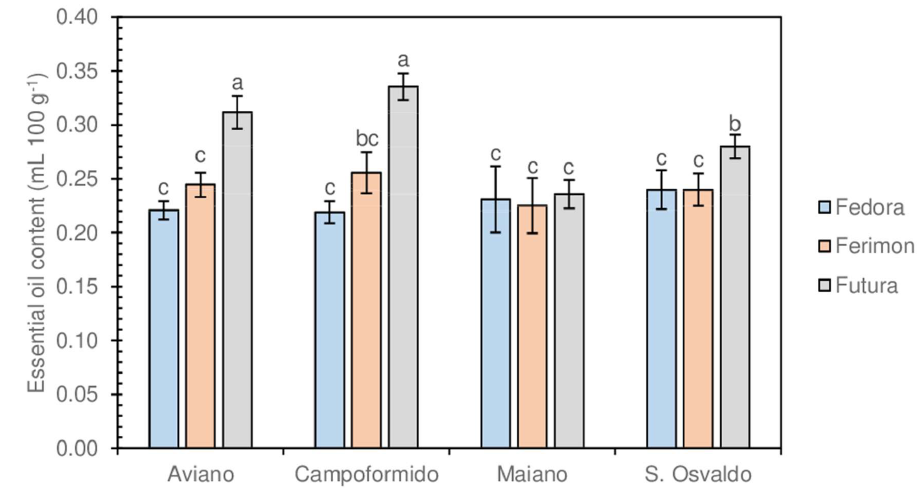
Figure 3. EOs content on hemp inflorescence dry weight. Means with the same letter are not significantly different. LSD at 5% level. Bars represent standard error.